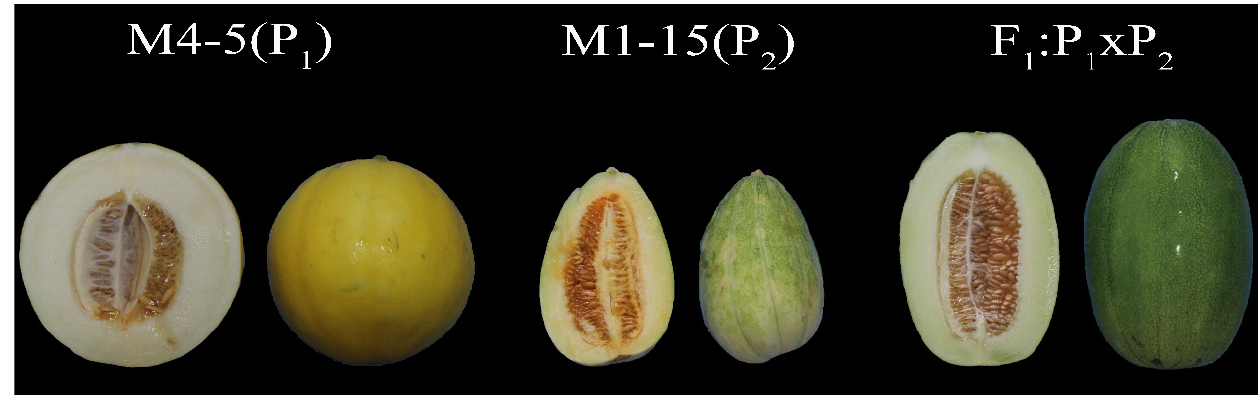
Figure 1. A picture of the melon parents (P 1 M4-5, P 2 M1-15) and F 1 progeny, showcasing their corresponding fruit longitudinal and lateral pro fi les.